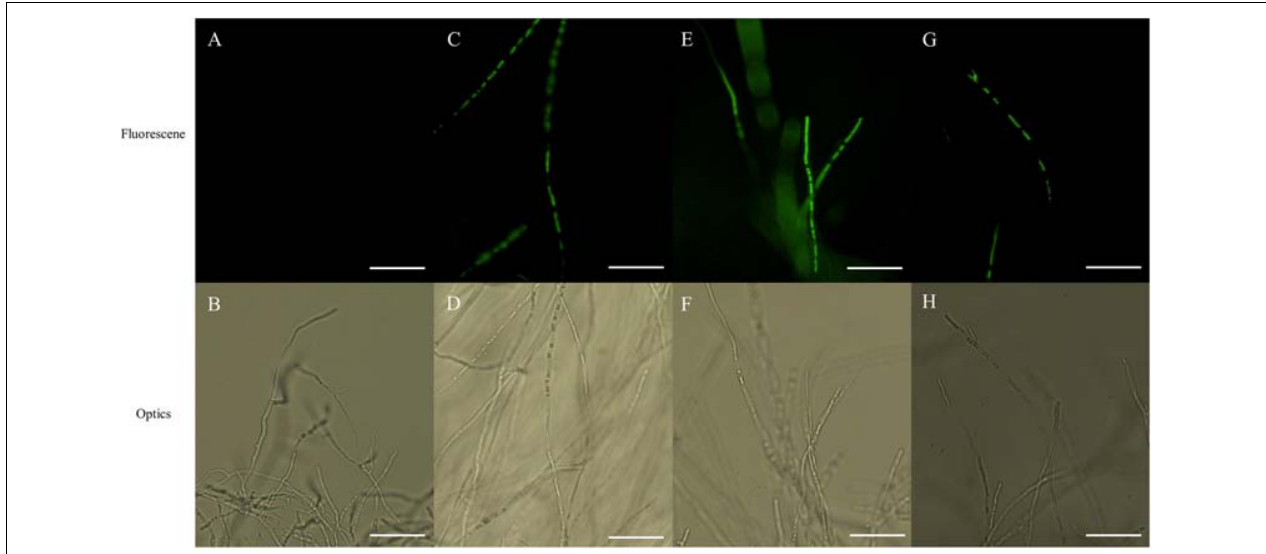
FIGURE 7 | Effects on reactive oxygen species (ROS) accumulation of Ps. camelliae-sinensis strain GZHS-2017-010 in response to treatment of hyphae with different concentrations of phenazine-1-carboxylic acid (PCA). (A,B) Control hyphae; (C,D) PCA-treated hyphae at the concentration of 6.38 µ g/ml PCA; (E,F) PCA-treated hyphae at the concentration of 11.23 µ g/ml PCA; and (G,H) PCA-treated hyphae at the concentration of 16.08 µ g/ml PCA. Bar = 50 µ m. Under fluorescence microscopy, ROS appeared as green fluorescence.